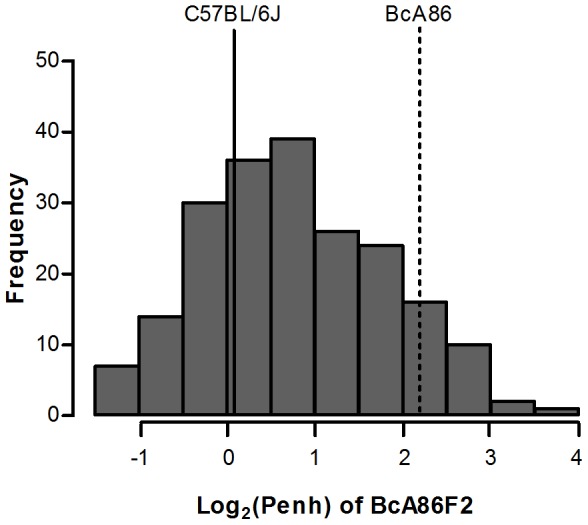
Histogram representation of the enhanced pause values of 205 BcA86F2.The distribution of log transformed enhanced pause values (log2(Penh)) of BcA86F2 mice ranges from lower than the average phenotype value of C57BL/6J (solid line) to greater than average phenotype value of BcA86 (dashed line).